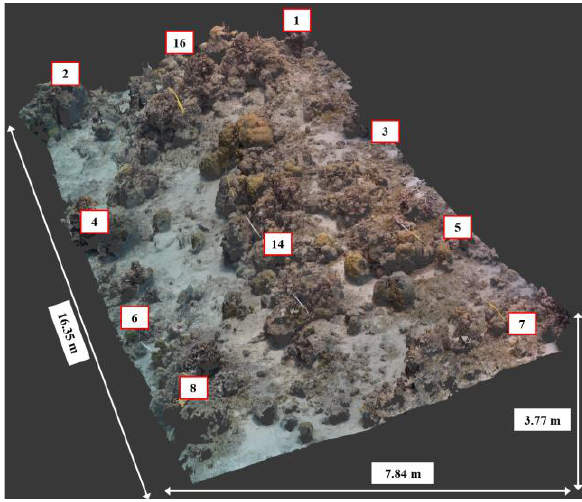
Fig.1: 3D photogrammetric point cloud from the January 2017 campaign along with the distribution and label of the installed ground control points (GCPs). Fig.3: GCP measurement configuration for (A) long poles, (B) short poles, and (C) their shared height difference observations.